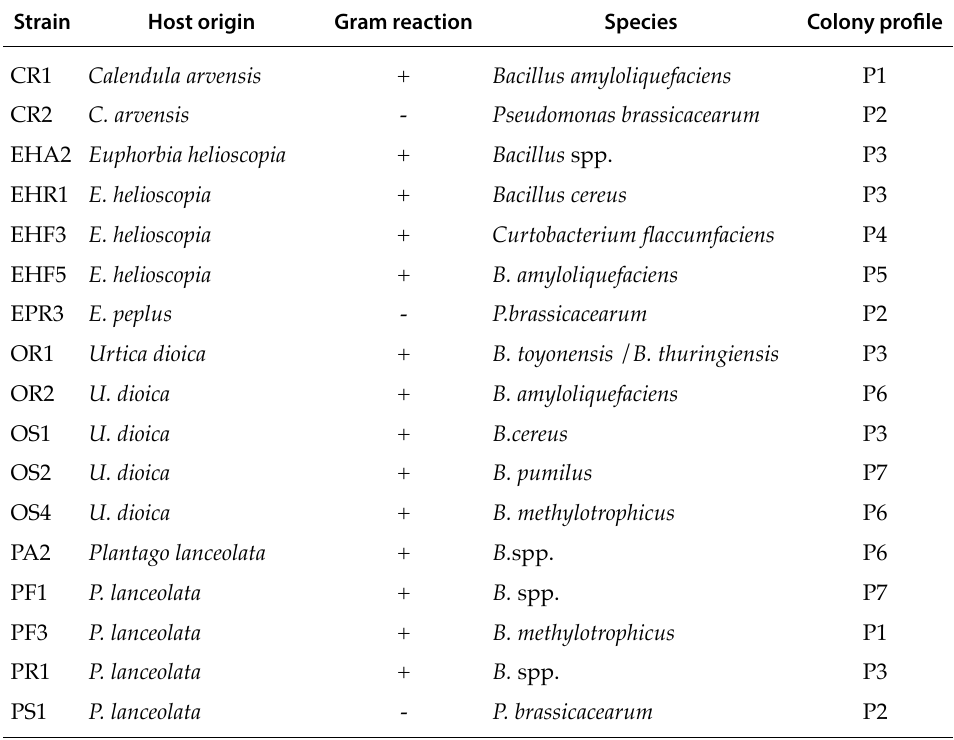
Table 1. Origin and characterisationof the most representative bacterial endophytes isolated from weeds.